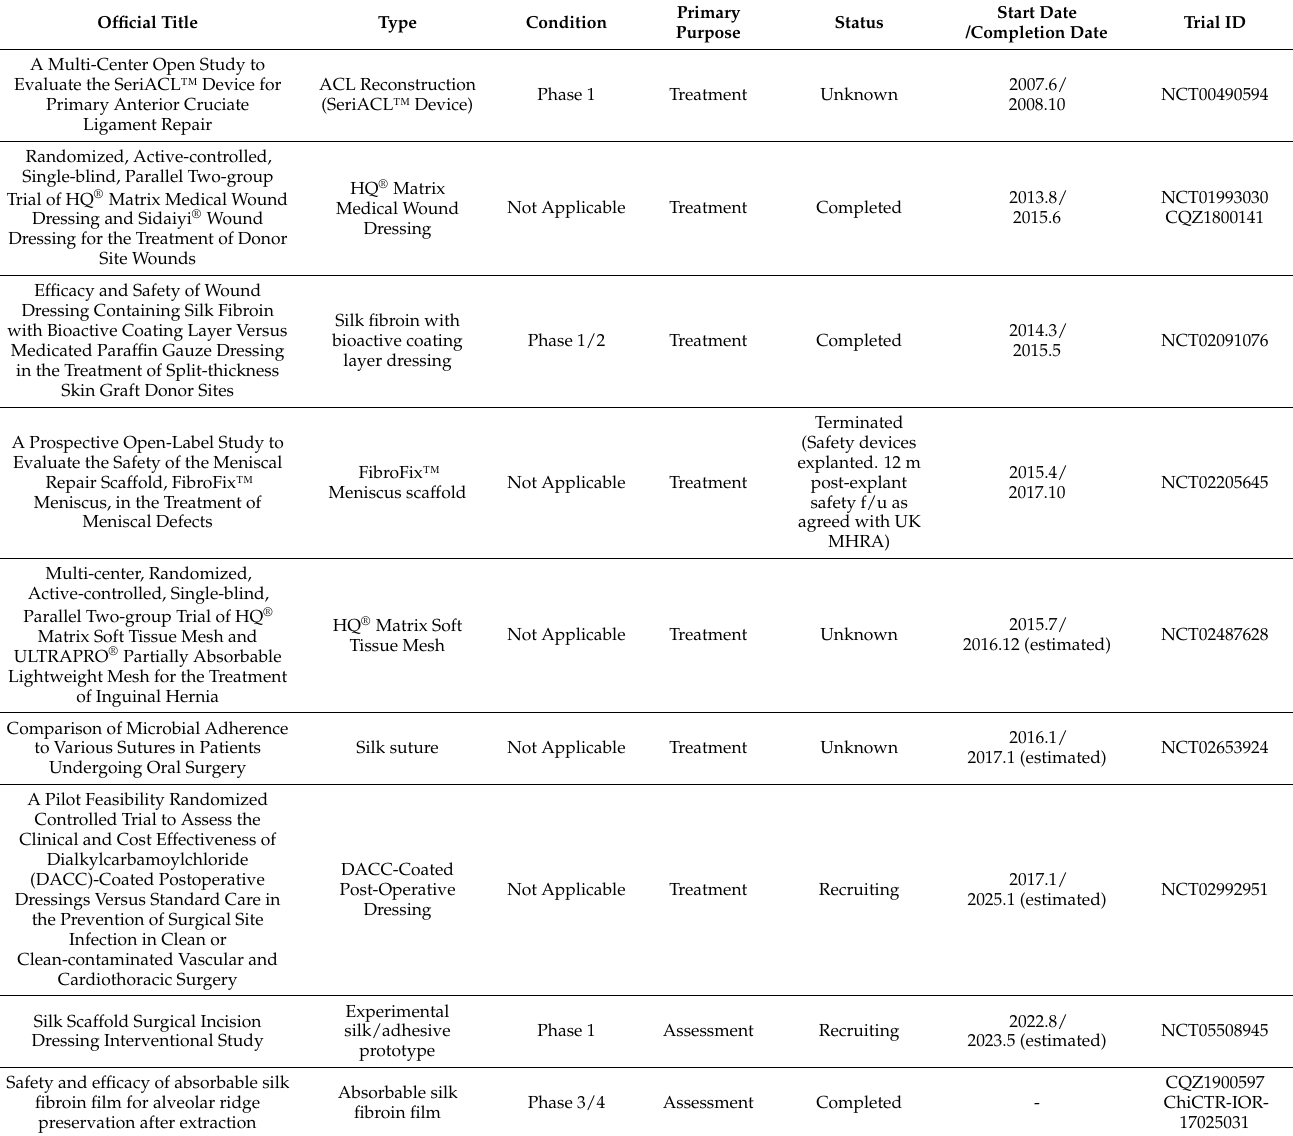
Table 2. Clinical trials of silk fibroin medical